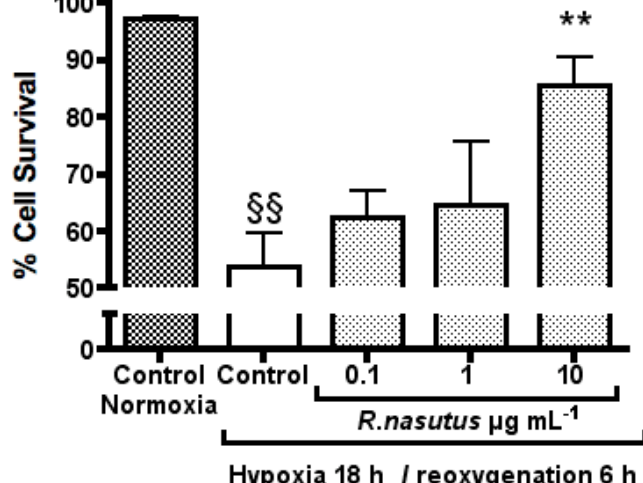
Figure 4. The protective effect of R. nasutus against against cell death caused by 18-hours hypoxia and 6-hours reoxygenation when added immediately before hypoxic condtions. Measured using the trypan blue exclusion assay. §§ One-way ANOVA Dunnett’s multiple comparison post hoc test normoxia control vs . hypoxia control P < 0.01. ** One-way ANOVA Dunnett’s multiple comparison post hoc test R. nasutus treated cells vs. hypoxia control P value < 0.01 n =